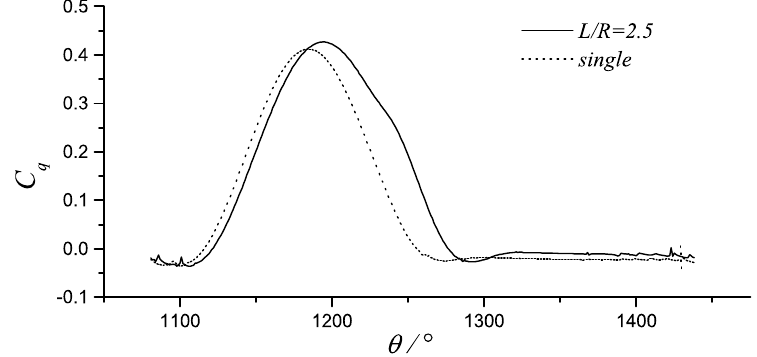
Figure 10. The variation law of single blade moment coefficient with azimuthal angle in parallel turbine where λ = 2.5.